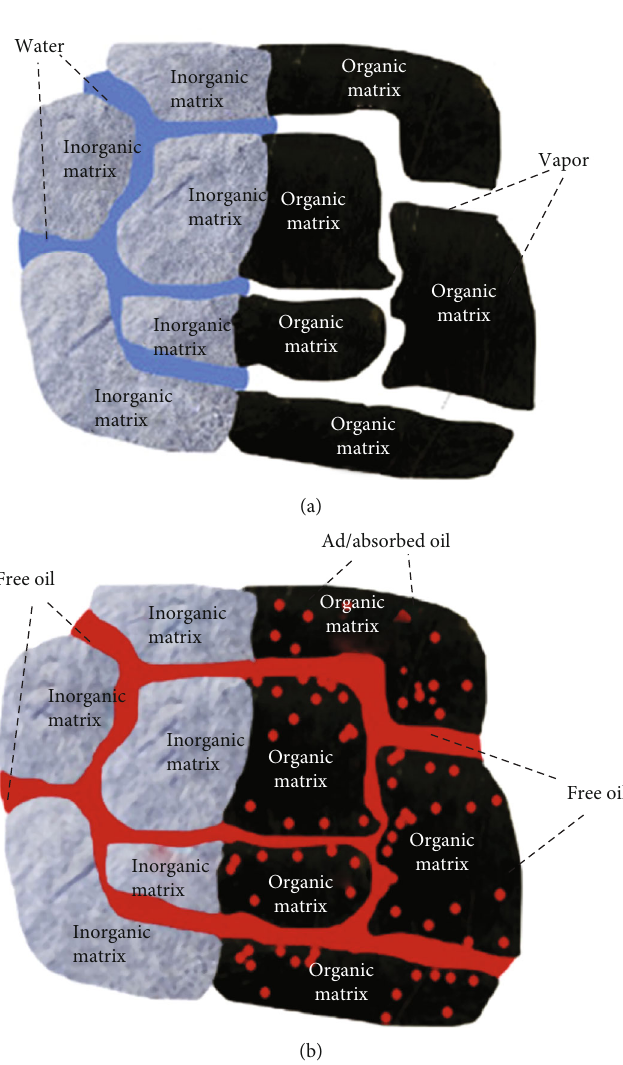
Figure 6: Schematic of di ff erent fl uids imbibition process and storage space in shale